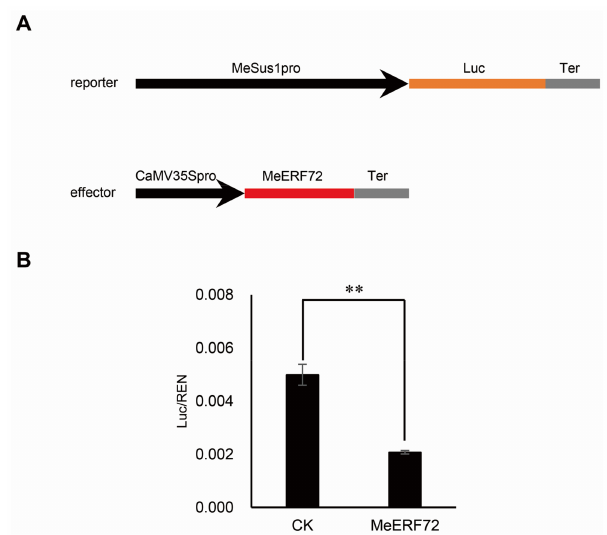
Figure 7. Repression of MeSus1 promoter in the transient expression system by MeERF72. ( A ) Reporter and effector vector sketches used in the transient expression assay; ( B ) Relative Luc activity of CK and MeERF72 in tobacco leaves. Error bars represent the SD of nine technical replicates, the significant difference is assessed by ANOVA, ** p <